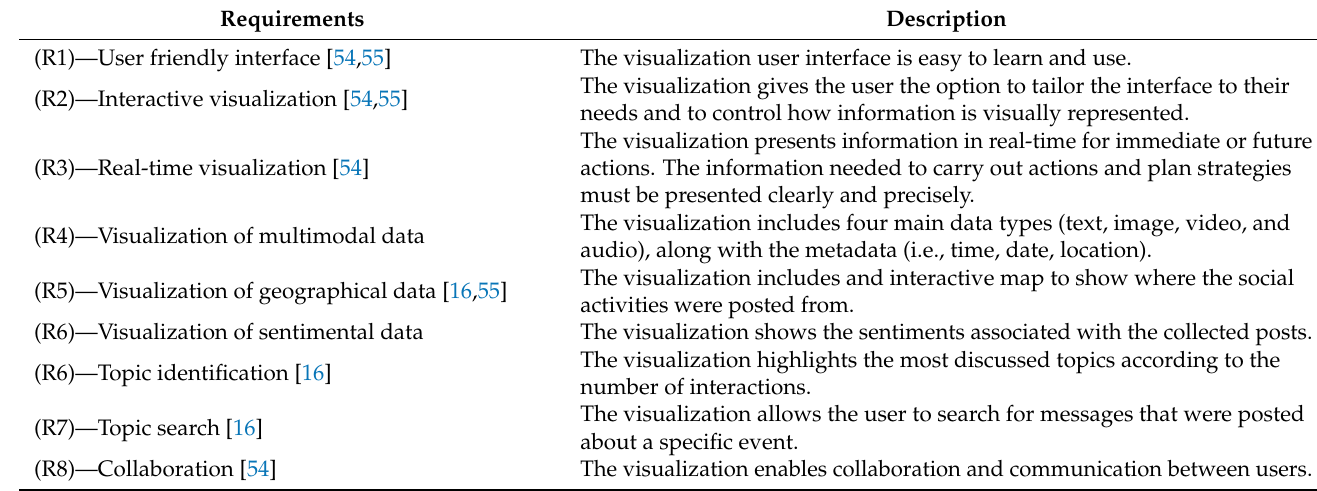
Table 2. High-level user requirements of disaster interaction